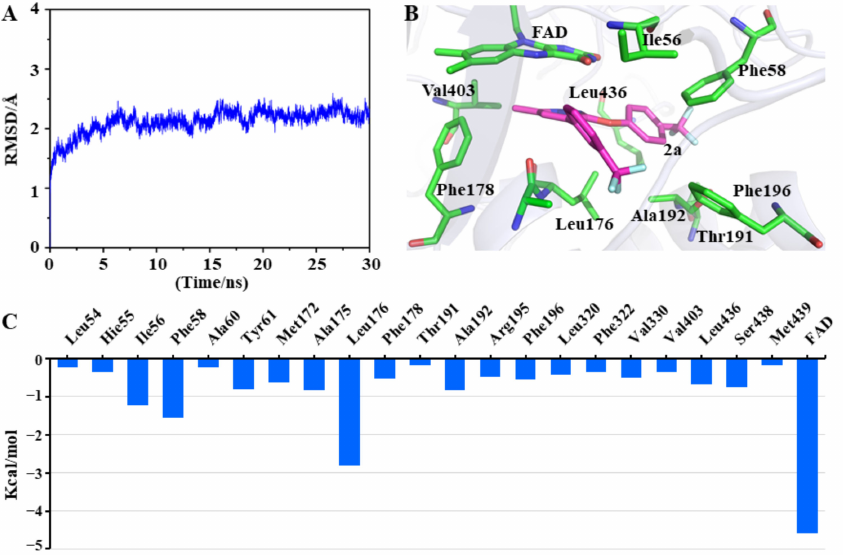
Figure 4. Molecular dynamic simulation study of the 2a - Synechococcus PDS system. ( A ) The root- mean-square deviation (RMSD) analysis of the C, CA, and N atoms during the MD simulation. ( B ) The binding mode of 2a to Synechococcus PDS at the last trajectory of MD simulation. ( C ) Decomposing of the binding free energy of the 2a – Synechococcus PDS complex, in the last 10 ns of the MD trajectories, using